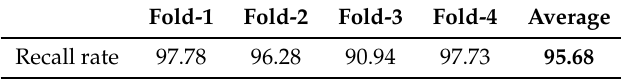
Table 1. The recall (%) of our candidate